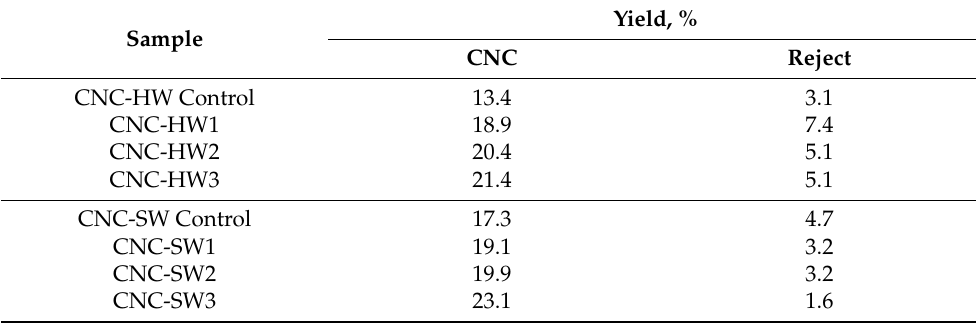
Table 4. Determination of CNC and reject yields from control and oxidized HW and SW pulps.